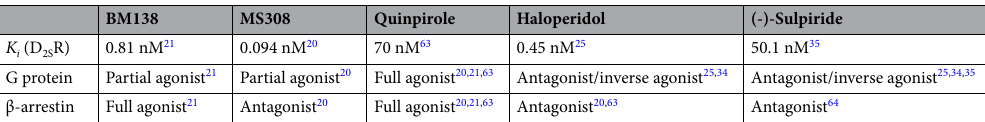
Table 1. K i values and efficacy of the ligands BM138, MS308, quinpirole, haloperidol and sulpiride.